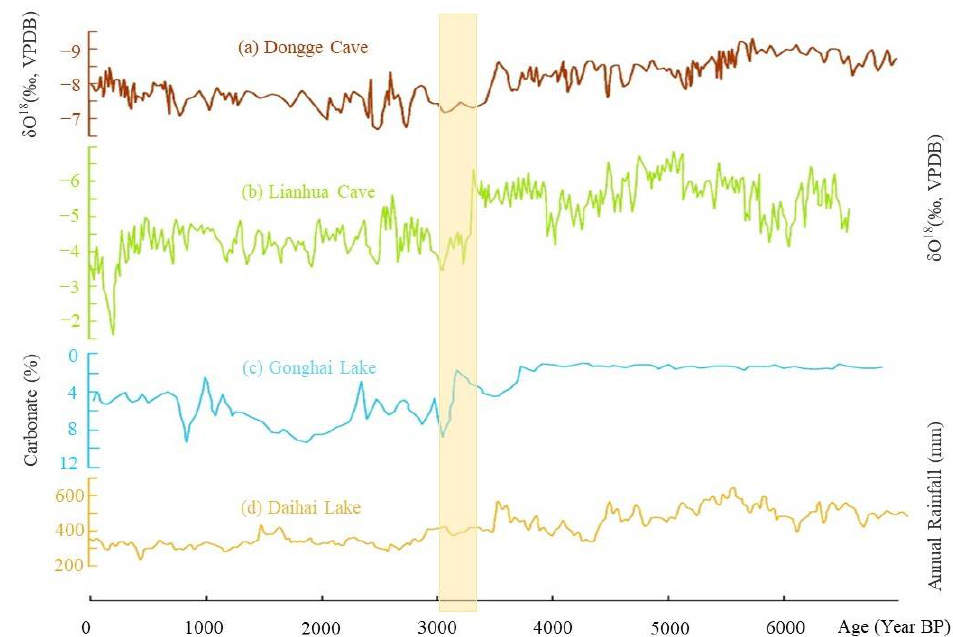
Figure 6. Proxies of climatic changes around the study area during the past 6000 years: ( a ) δ 18 O sequences from Dongge Cave [56]; ( b ) δ 18 O sequences from Lianhua Cave [57]; ( c ) carbonate sequences from Gonghai Lake [58]; ( d ) annual rainfall reconstruction based on pollen assemblages at Daihai Lake [59]. Light-yellow strip indicates the Yinxu period (~3250–~3000 BP).